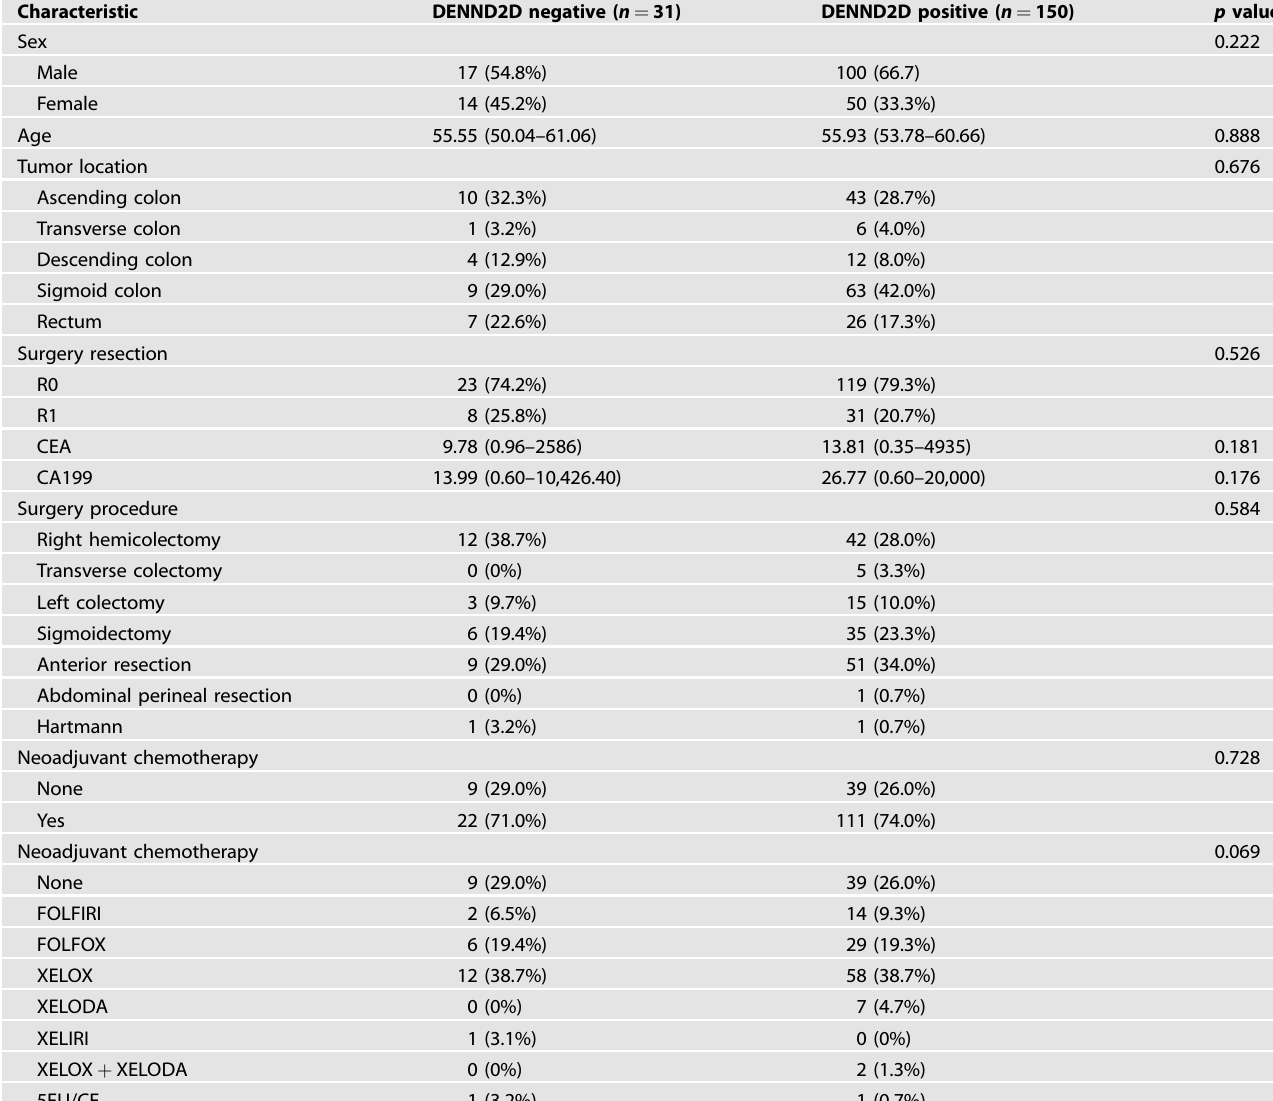
Table 1. Clinicopathologic characteristics of stage IV CRC